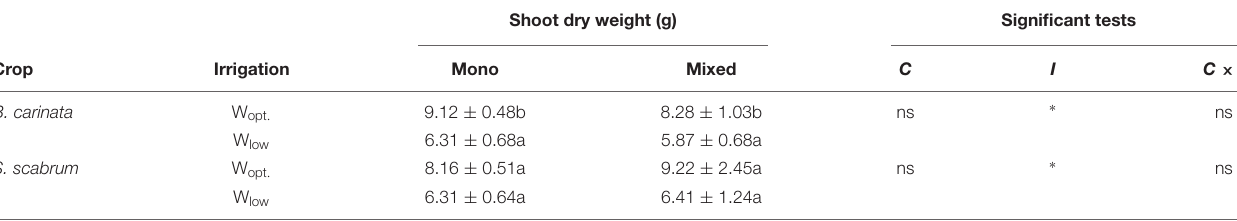
TABLE 1 | Shoot dry weight of B. carinata and S. scabrum at harvest (g/plant).